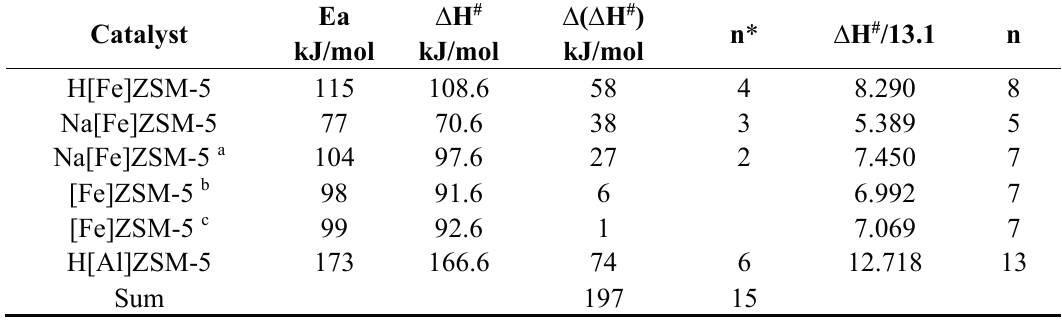
Table 1. Experimental data and subsequent treatment. ∆ H # = Ea − RT, where T is a mean value (770 K) for the temperature range of the measurements. ∆ ( ∆ H # ) = abs ( ∆ H # n* means the number of a certain common term that seems to appear in such a difference. A vibrational quantum number is estimated as described in the